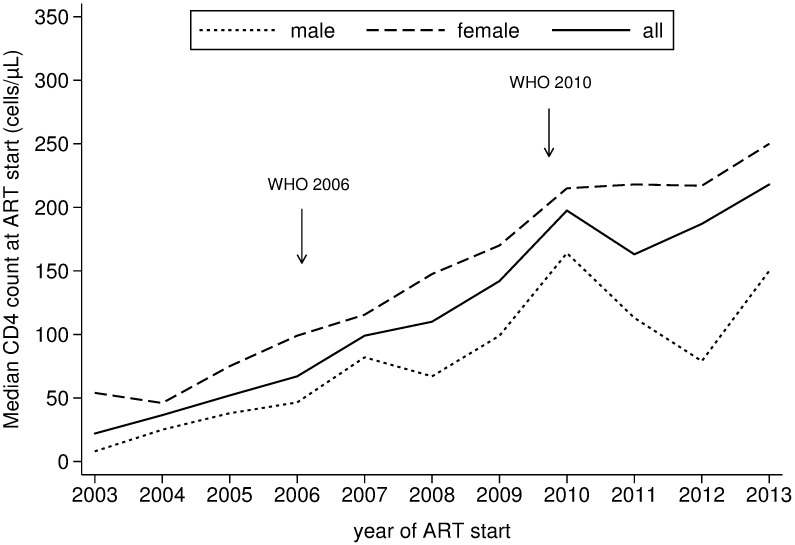
Evolution in baseline CD4 cell counts in adults initiating antiretroviral treatment.The arrows indicate the time revised WHO guidelines were implemented.